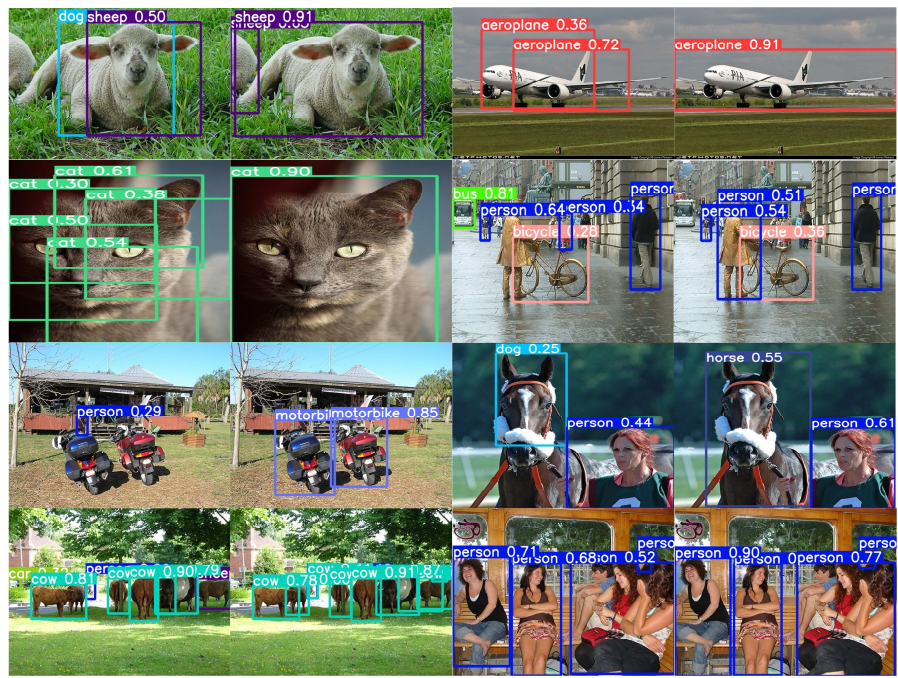
Figure 13. Comparison of simulation results of YOLOv5s and YOLOv5s_ours on Pascal VOC2007 + VOC2012 dataset.